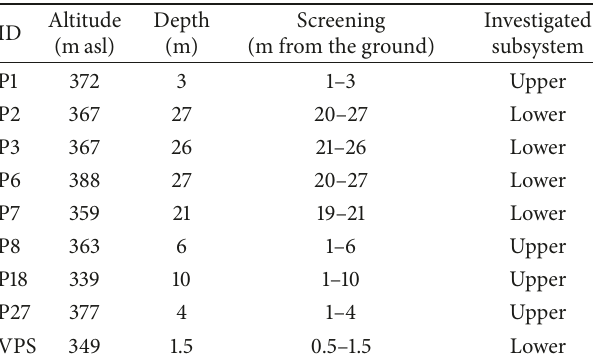
Table 1: Main features of the observation